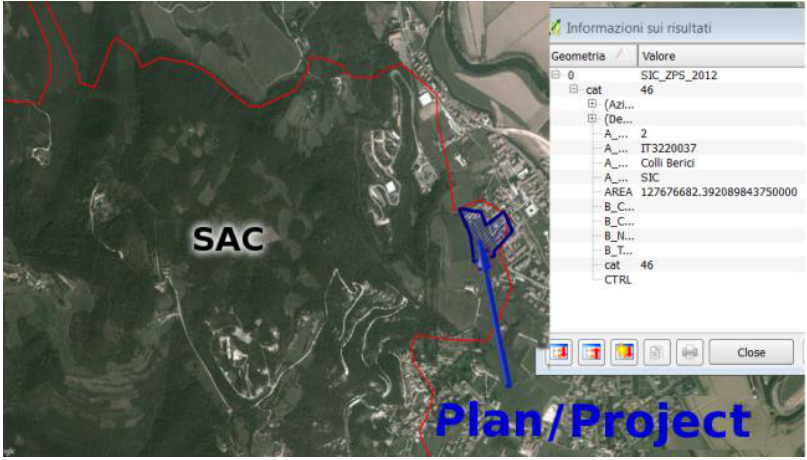
Figure 10. Area overlap of plan and project with the SAC.